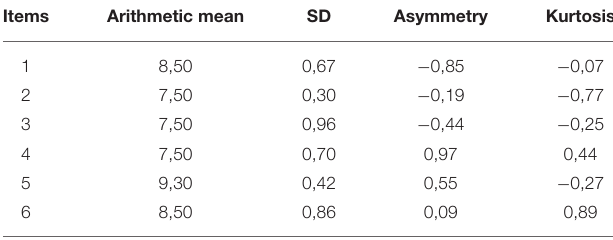
TABLE 1 | Descriptive statistical analysis of the Academic Activity Scale in Study 1 with blended learning.